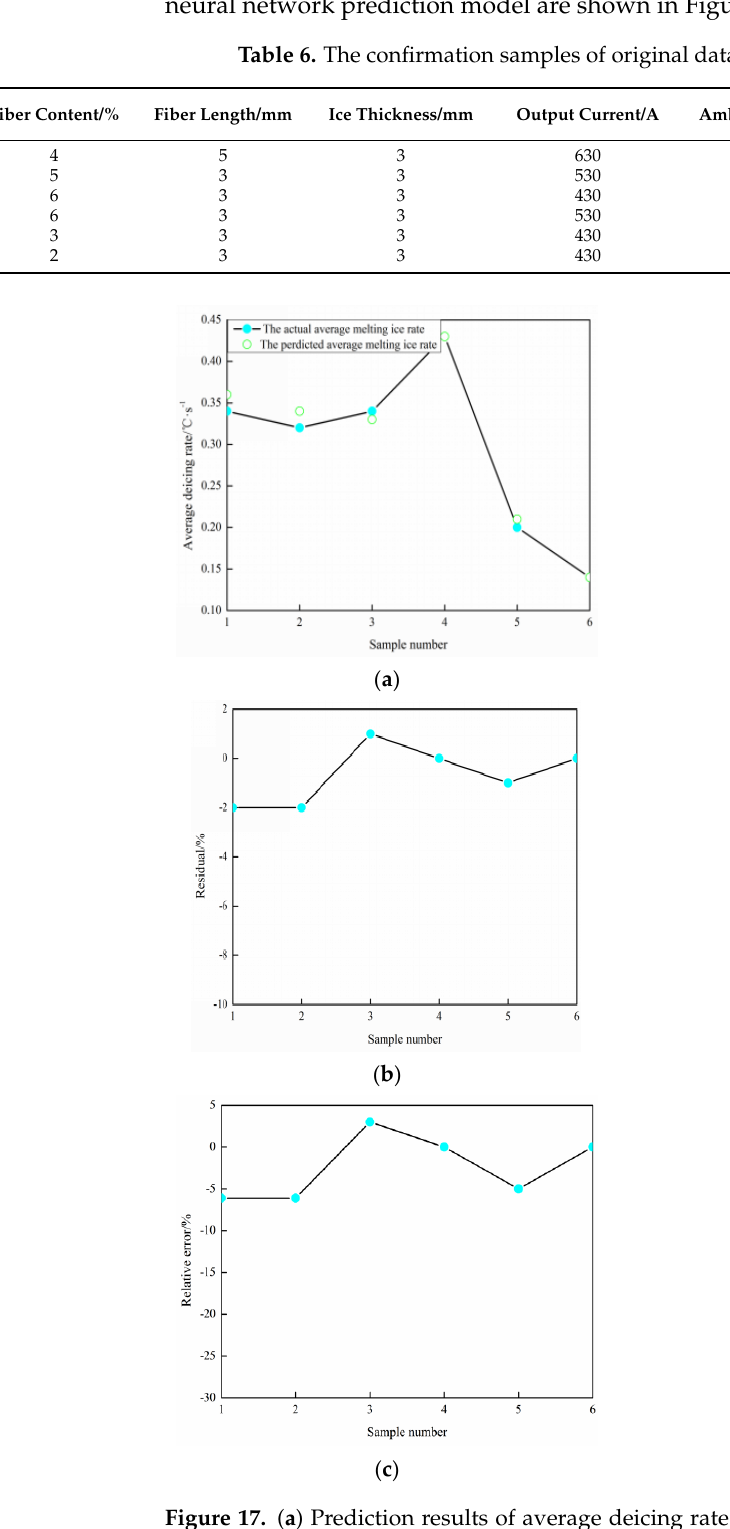
Figure 17. ( a ) Prediction results of average deicing rate by BP neural network prediction model; ( b ) Prediction results of residual by BP neural network prediction model; ( c ) Prediction results of relative error by BP neural network prediction model.